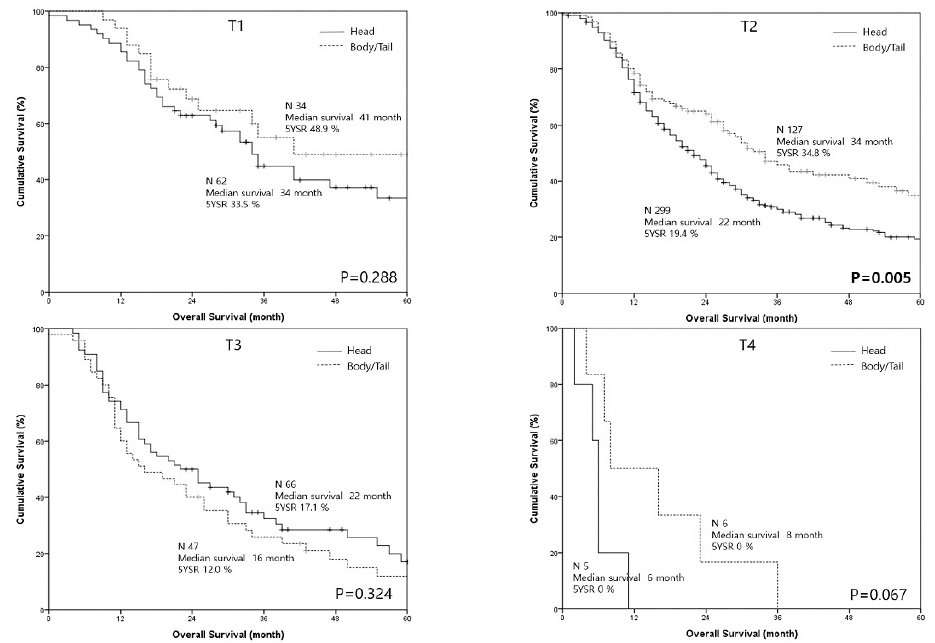
Figure 3. The survival curves of pancreas head / uncinate cancer and pancreas body cancer according to the T categories.